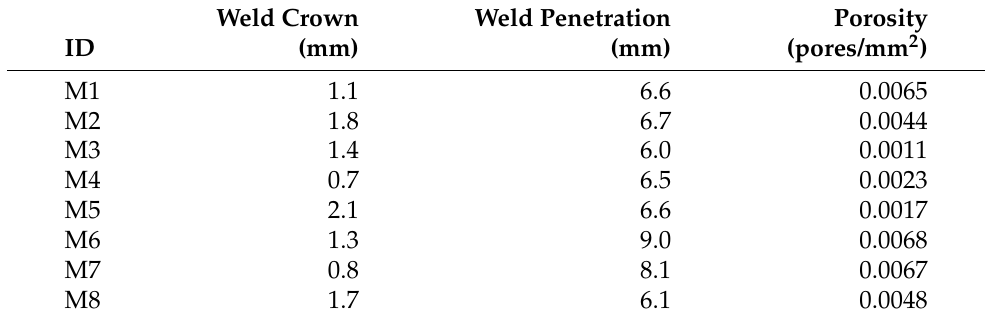
Table 4. Evaluation of weld crown, weld penetration, and porosity in the welded samples.